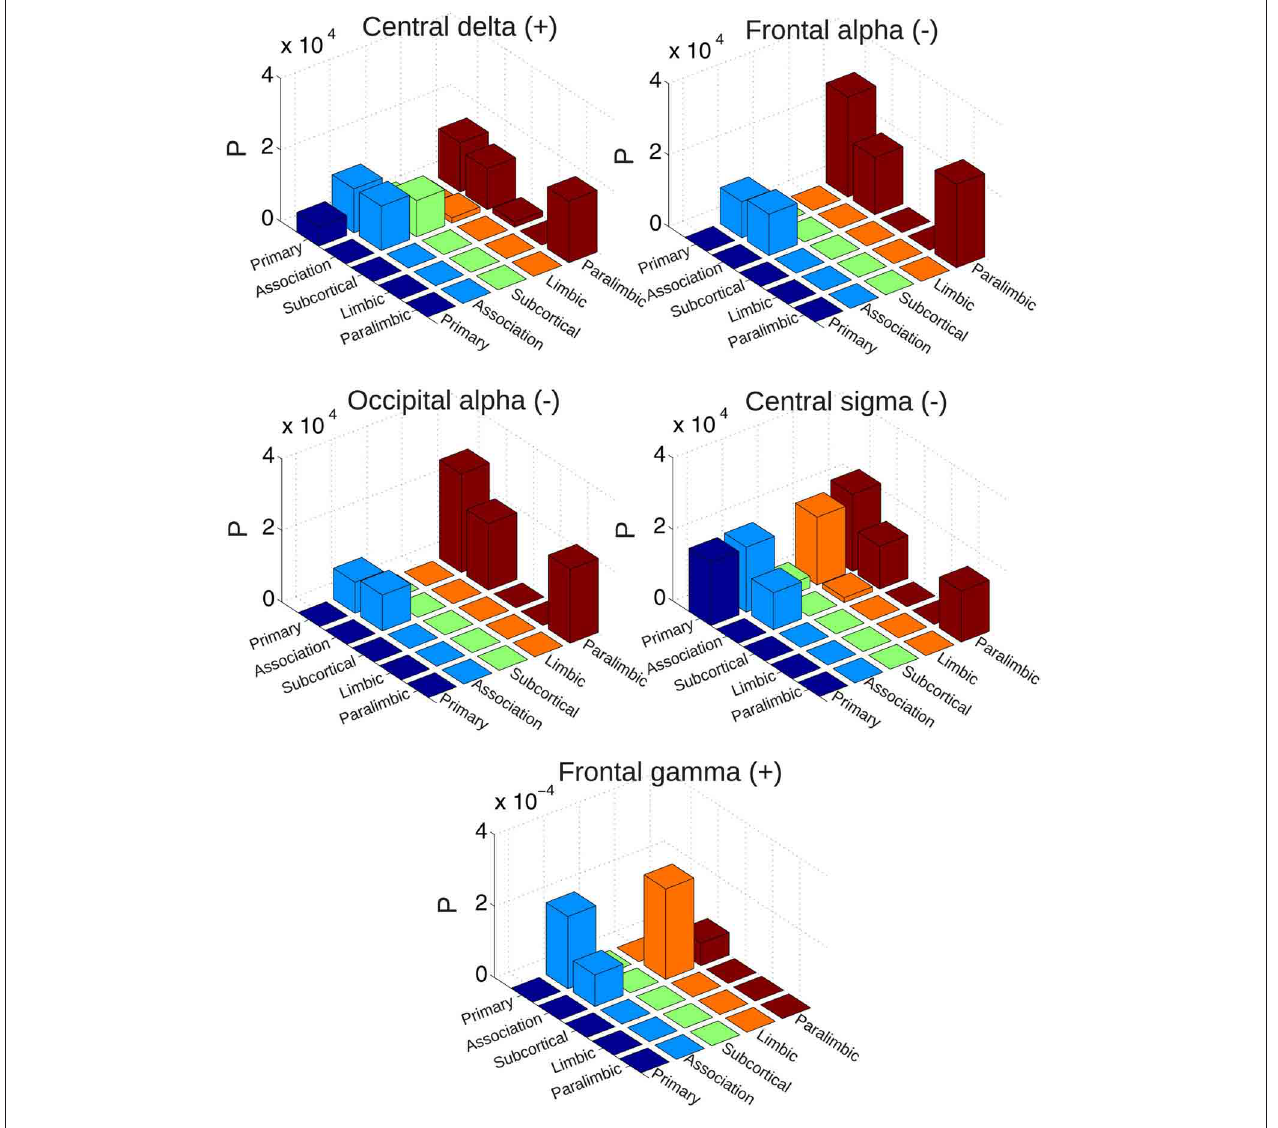
FIGURE 9 | Probability of finding connections between different systems (sensory, association, subcortical, limbic, and paralimbic) which correlate either positively or negatively with spontaneous EEG power